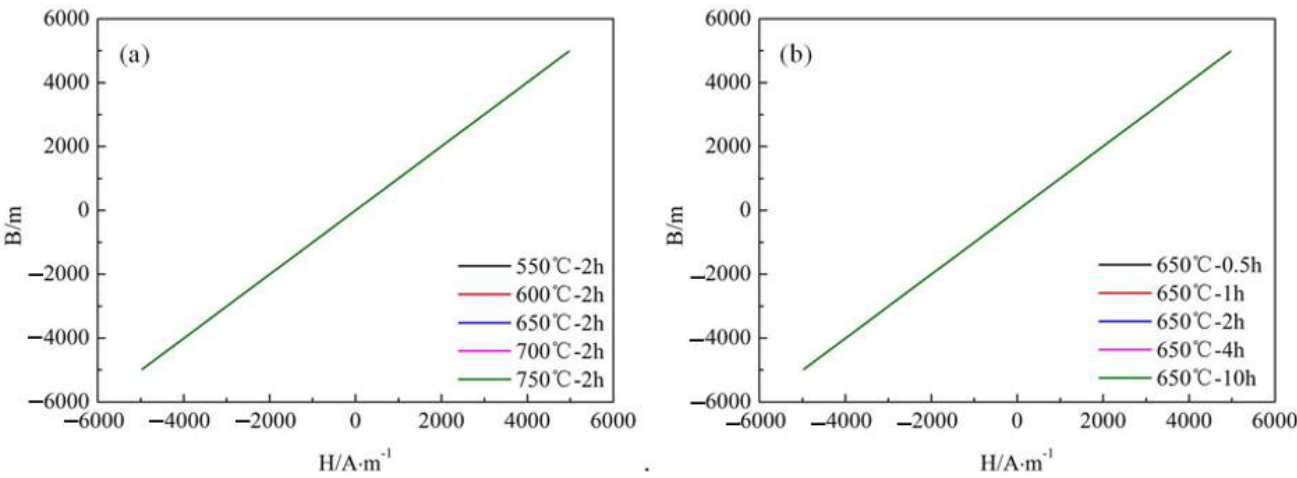
Figure 8. Hysteresis loop of experimental steel under different aging treatment conditions. ( a ) Different temperatures with 2 h, ( b ) 650 °C with different time.